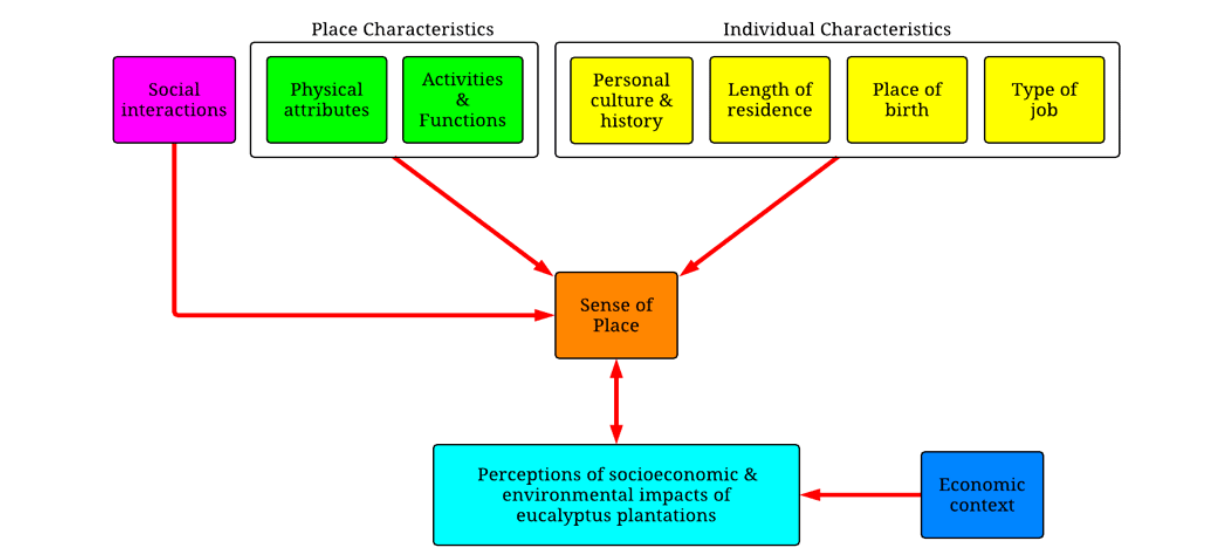
Fig. 4 . Relationship between sense of place and perceptions of socioeconomic and environmental impacts of eucalyptus